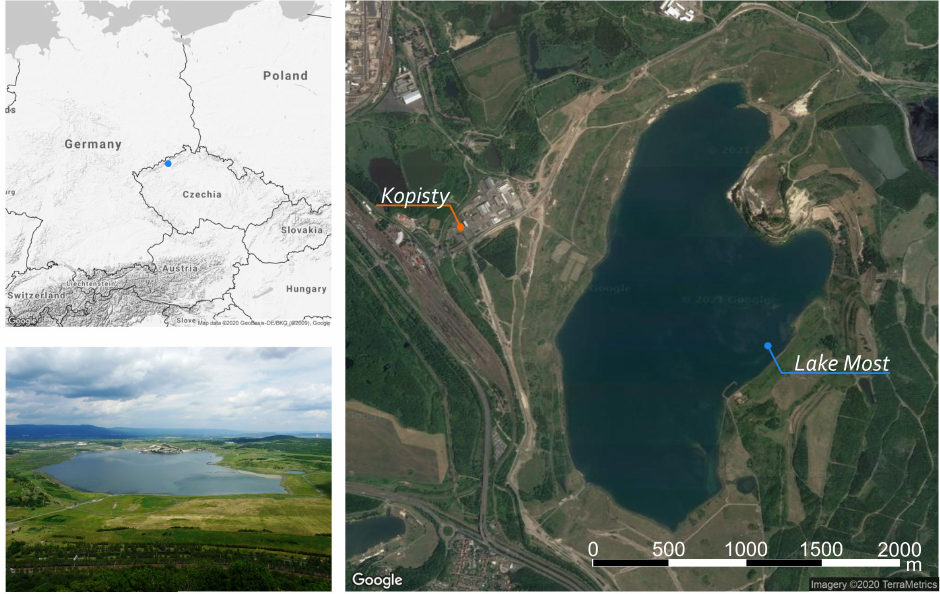
Figure 1. Lake Most and the surrounding area (source: www.pku.cz, Google